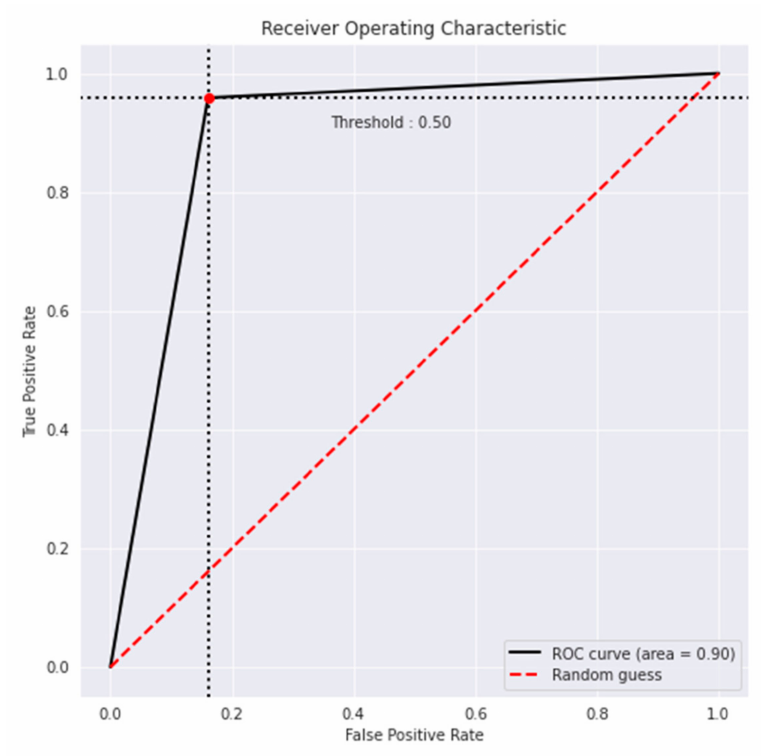
Figure 11. The ROC (receiver operating characteristic) curve analysis of POP at different thresh- old